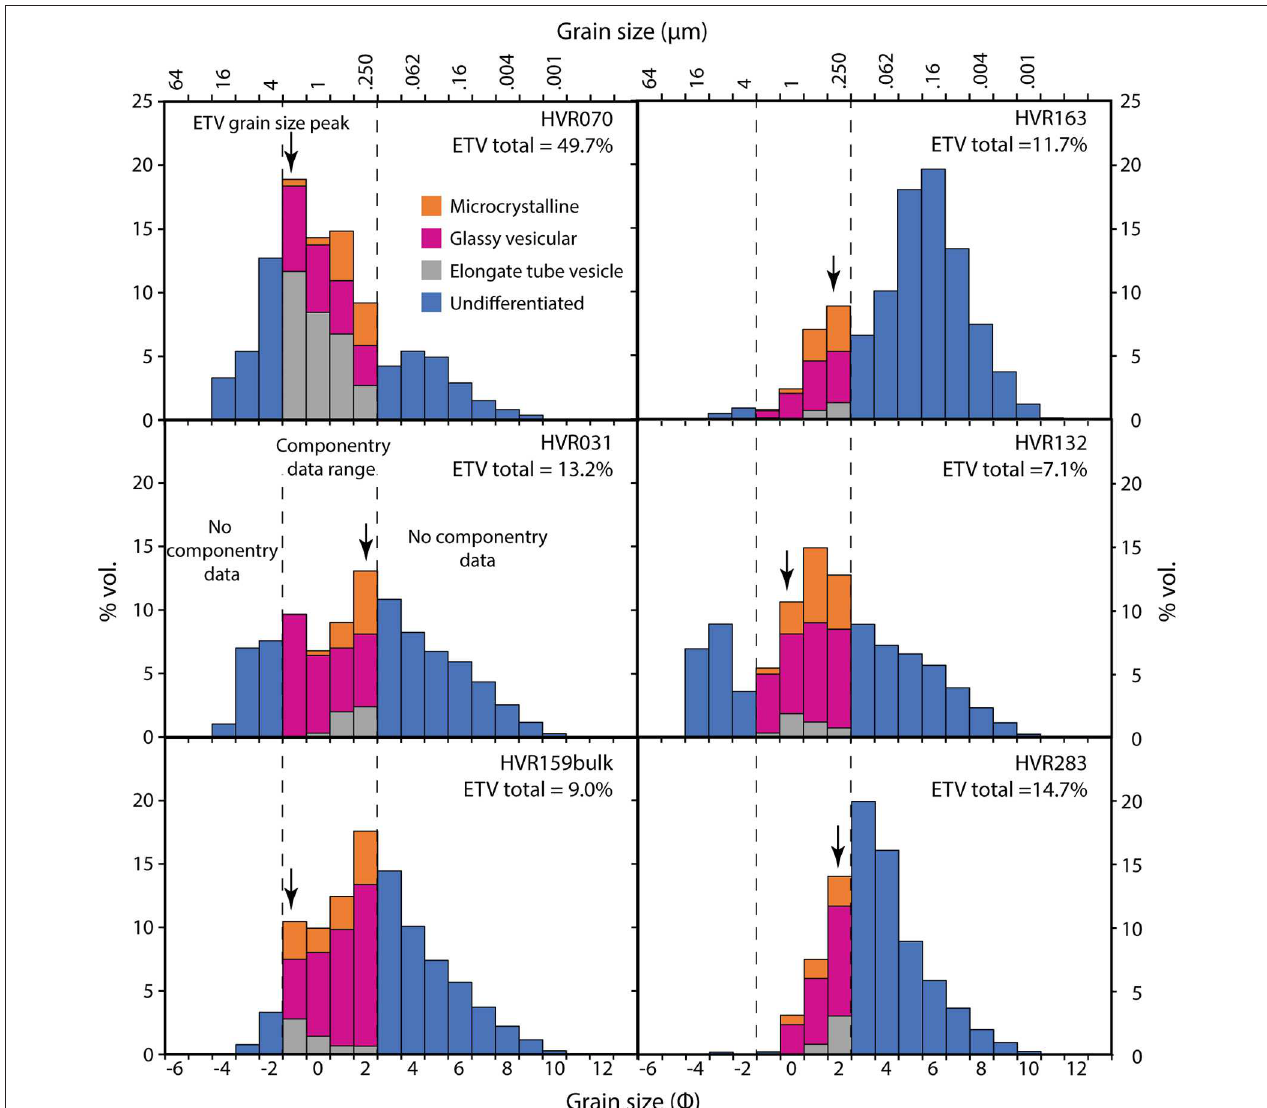
FIGURE 3 | The granulometry of six samples containing Elongate tube-vesicle particles indicates the presence of S3. Componentry results for grainsize fraction fractions from − 1 to 2 8 (2 to 250 µ m) in 1 8 steps are shown; Elongate tube-vesicle (ETV) particles = gray, glassy vesicular particle = pink, and microcrystalline particles = orange. ETV total indicates the wt % percentage of Elongate tube-vesicle particles in each componentry range. ETV particles of median (arrows) and maximum size are